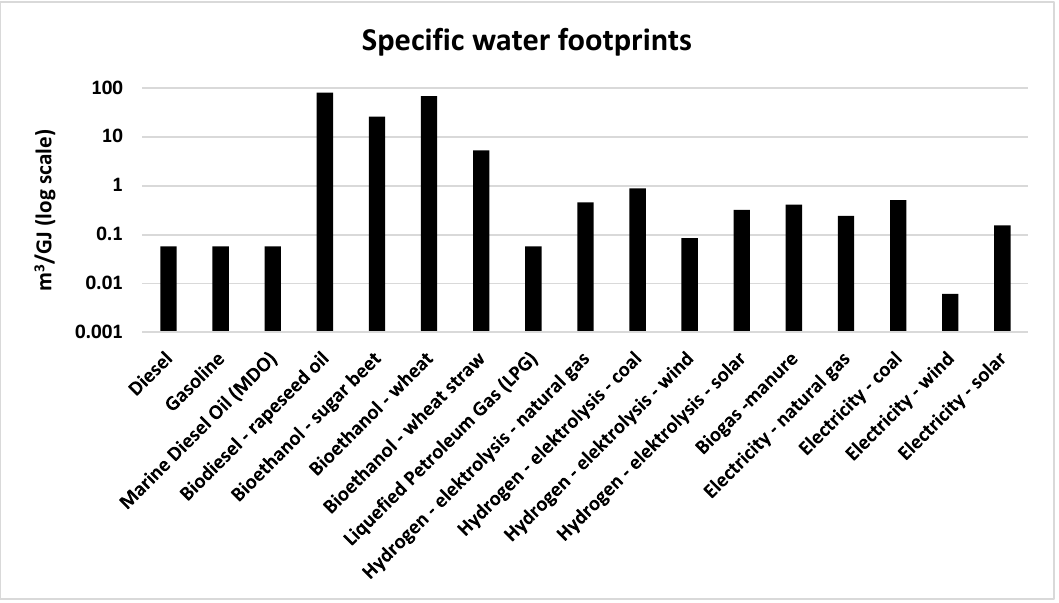
Figure 4. Specific total water footprints per fuel and related primary energy source on a logarithmic scale (m 3 /GJ).